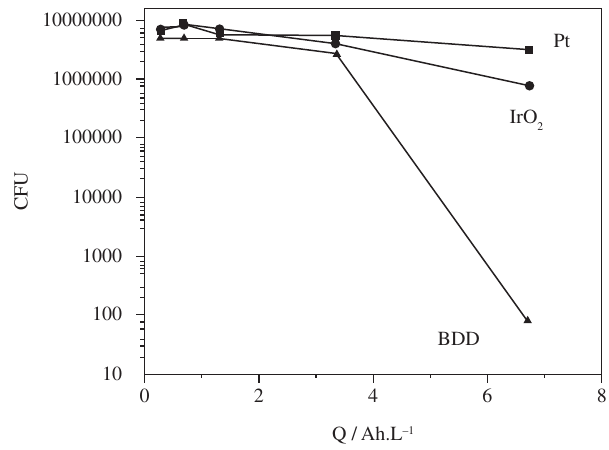
Figure 5. Disinfective performance of diamond electrodes in comparison to com- mon electrode materials: sterilization of a bacteria (14 x 10 7 CFU = colony form- ing units of E. coli ) and sugar (glucose COD 9 g O